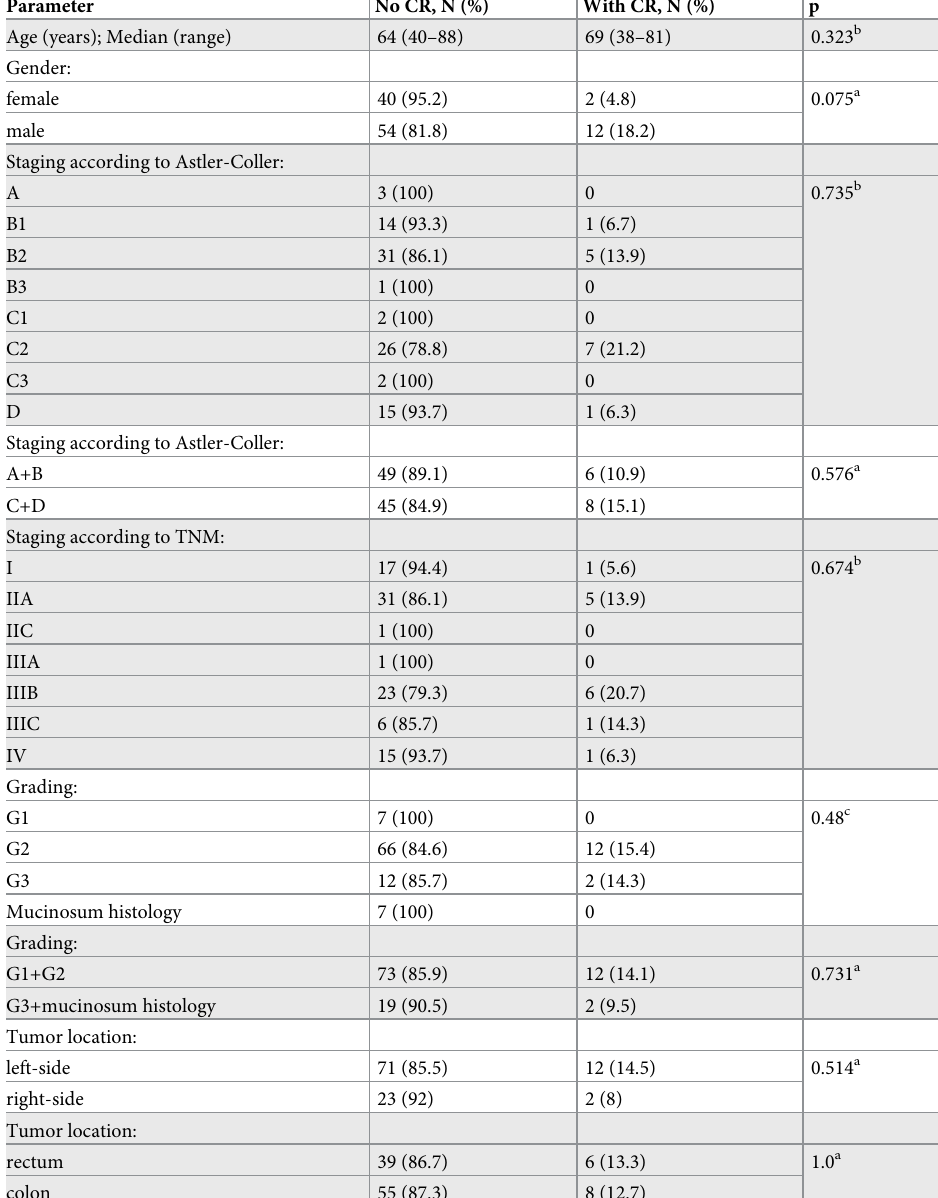
Table 3. Associations between Cryptosporidium spp. infection (CR) and various clinical parameters in the group of individuals with colorectal cancer (n = 108). Parameter No CR, N (%) With CR, N